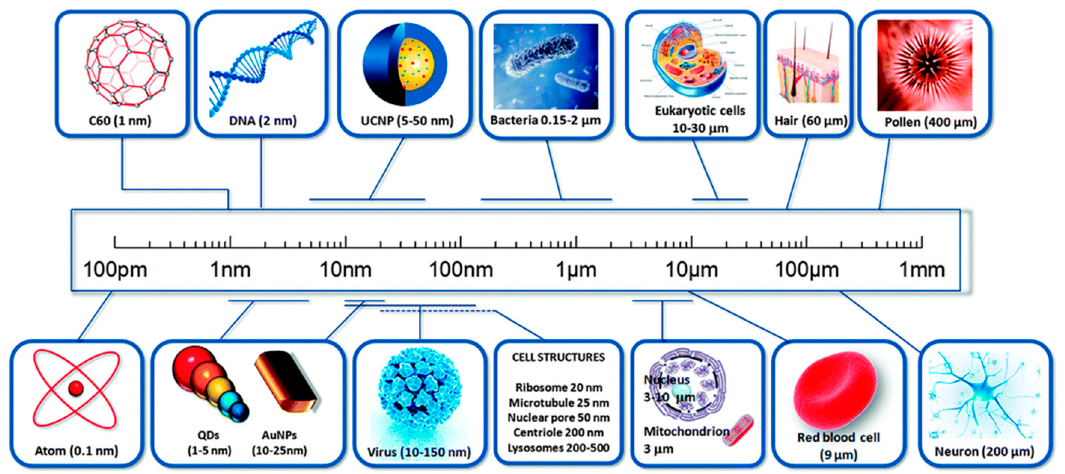
Figure 1. A comparison of sizes of nanomaterial. Reproduced with permission from reference [2].